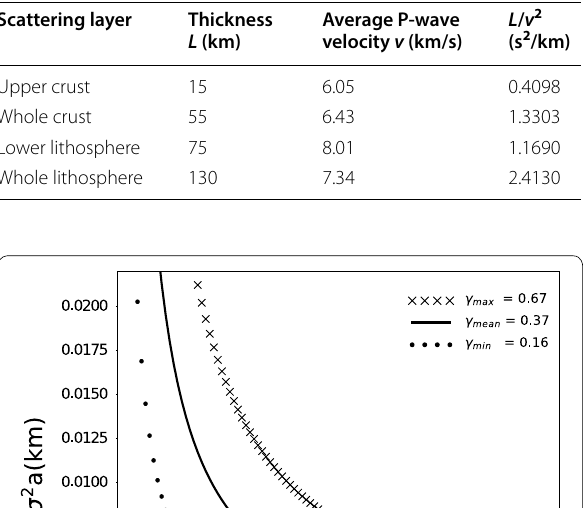
Fig. 8 Plot of the parameters σ 2 a versus the quantity L / v 2 of the scattering layer for three γ values